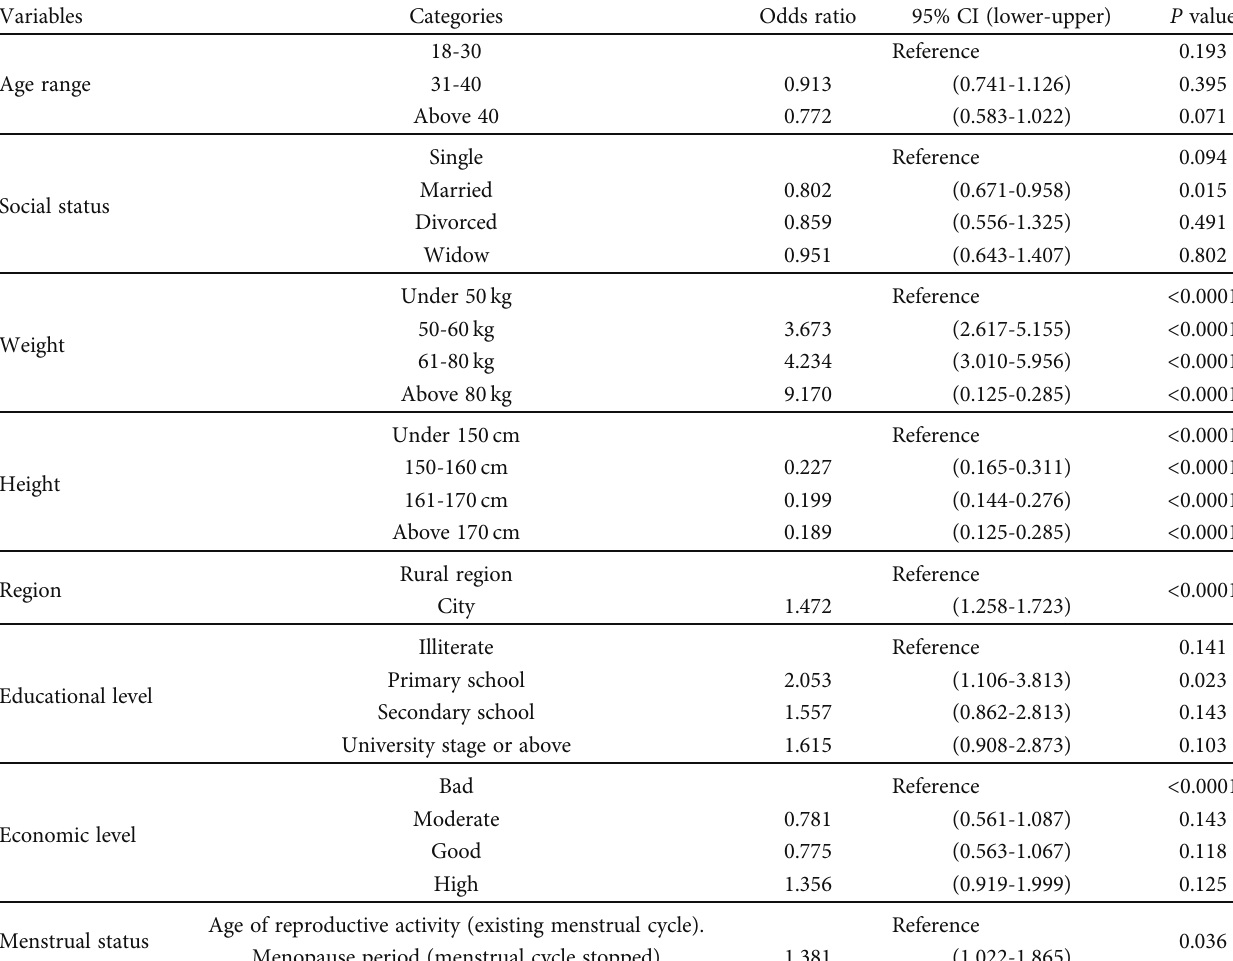
Table 4: Binominal logistic regression for predicting adequate knowledge towards osteoporosis among the study